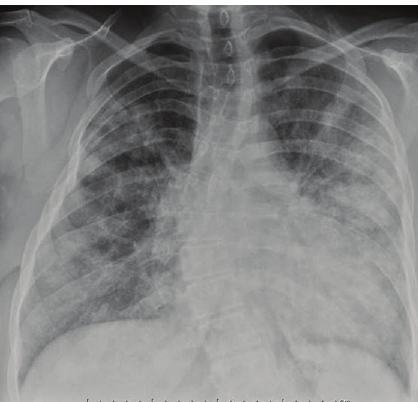
Figure 1: Showing the chest radiograph posteroanterior view. The cardiac silhouette is mildly enlarged but stable. The hilar structures are unremarkable. There are diffuse bilateral air space opacities. There is S-shaped thoracolumbar scoliosis.